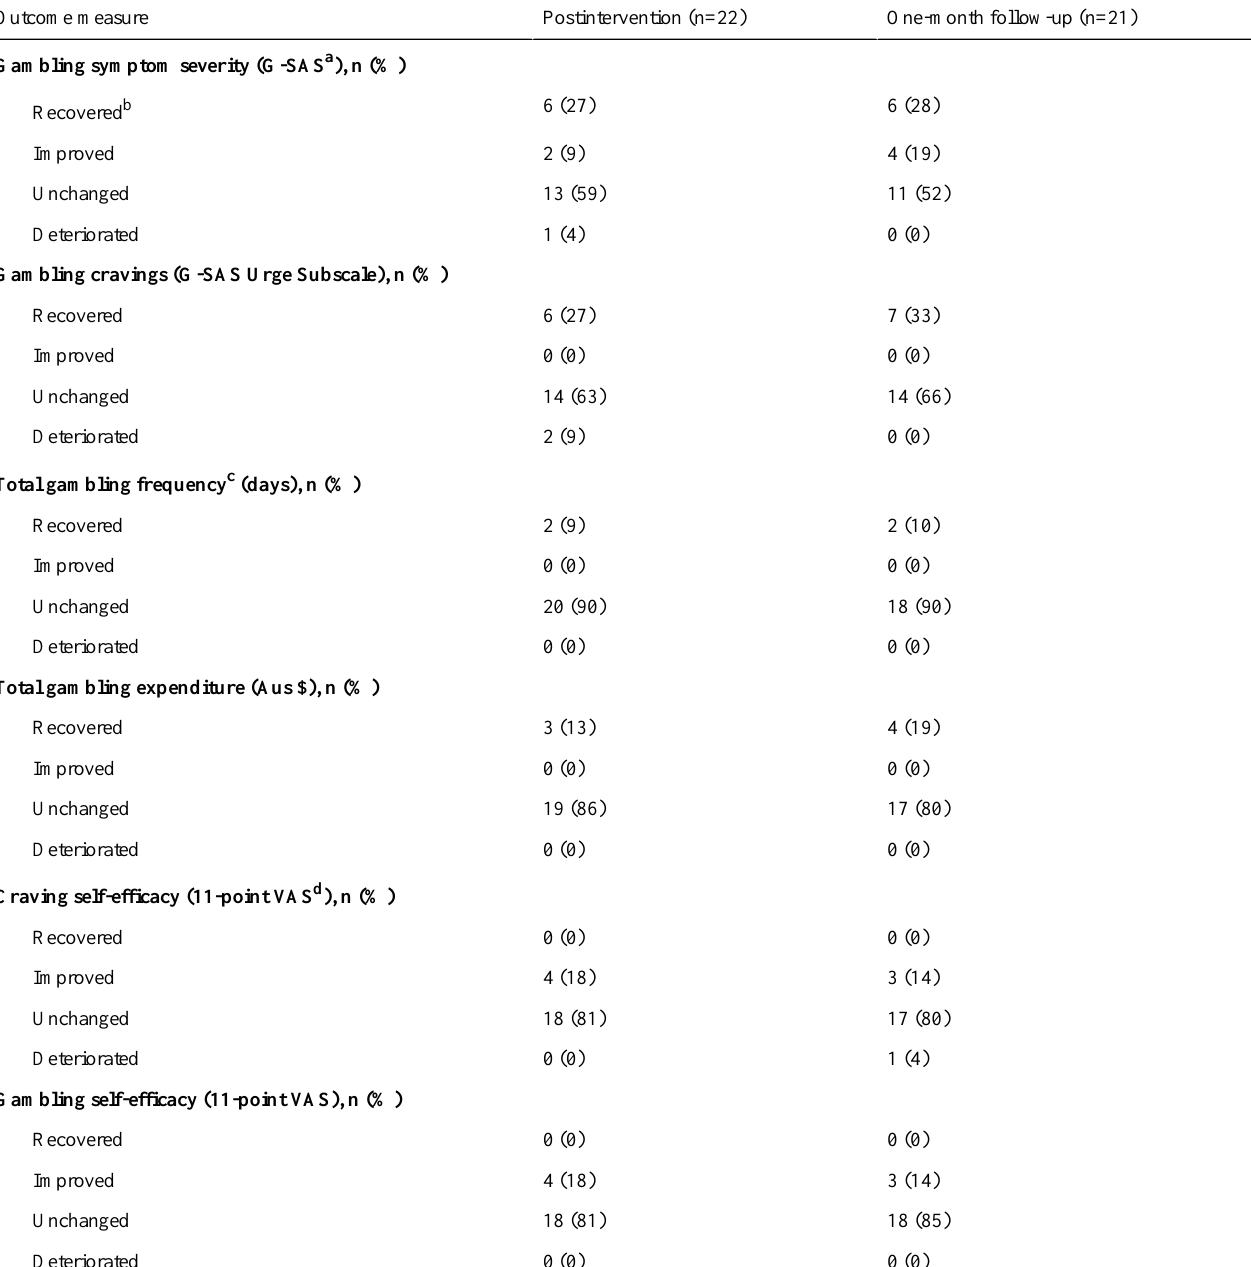
Table 6. Clinically significant changes in outcome measures at postintervention (n=22) and 1-month follow-up (n=21)